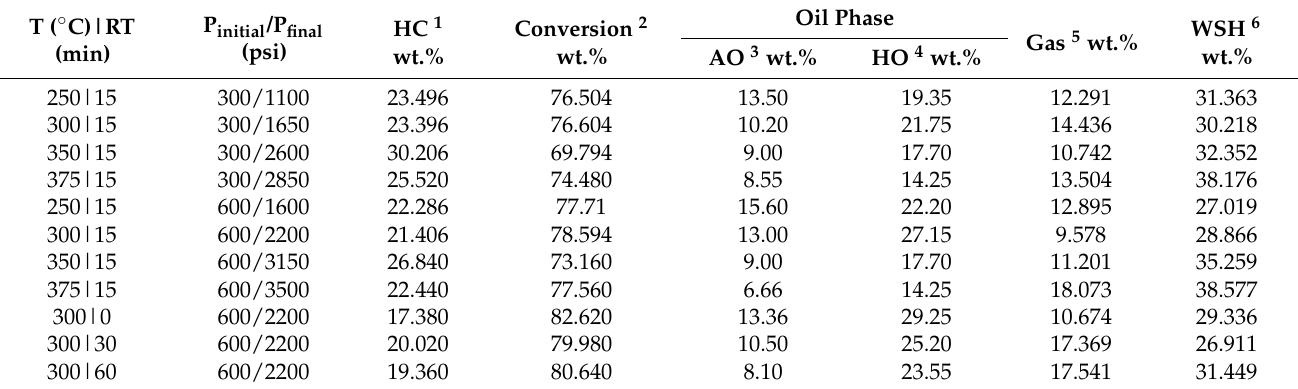
Table 1. Product distribution at different conditions of temperature, pressure, and retention time (Adapted from